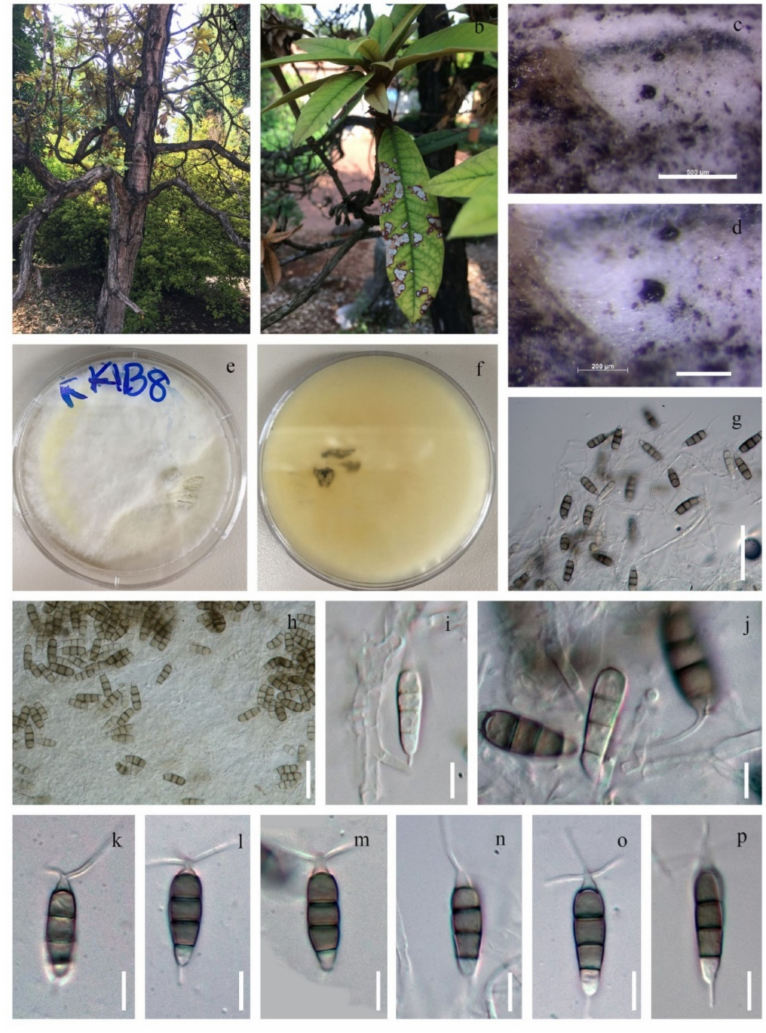
Figure 6. Neopestalotiopsis rhododendricola (KUN-HKAS 123204). ( a ) The habitat of the host plant ( Rhododendron sp.); ( b ) Pycnidia with drops of conidial exudate on the leaf surface; ( c , d ) colonies growing on PDA; ( e , f ) culture; ( g – j ) conidiogenous cells and developing conidia; ( k – p ) conidia. Scale bars: ( c ) 500 µ m; ( d ) 200 µ m; ( h ) 20 µ m; ( i – p ) 10 µ